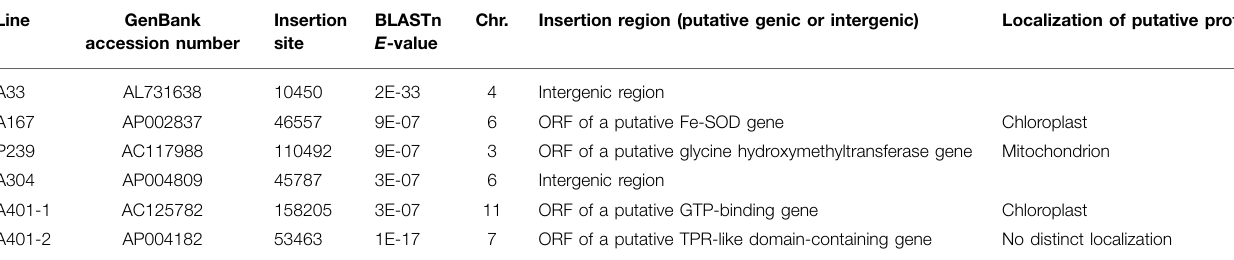
TABLE 1 | Locations of the T-DNA insertion and tagged putative genes.